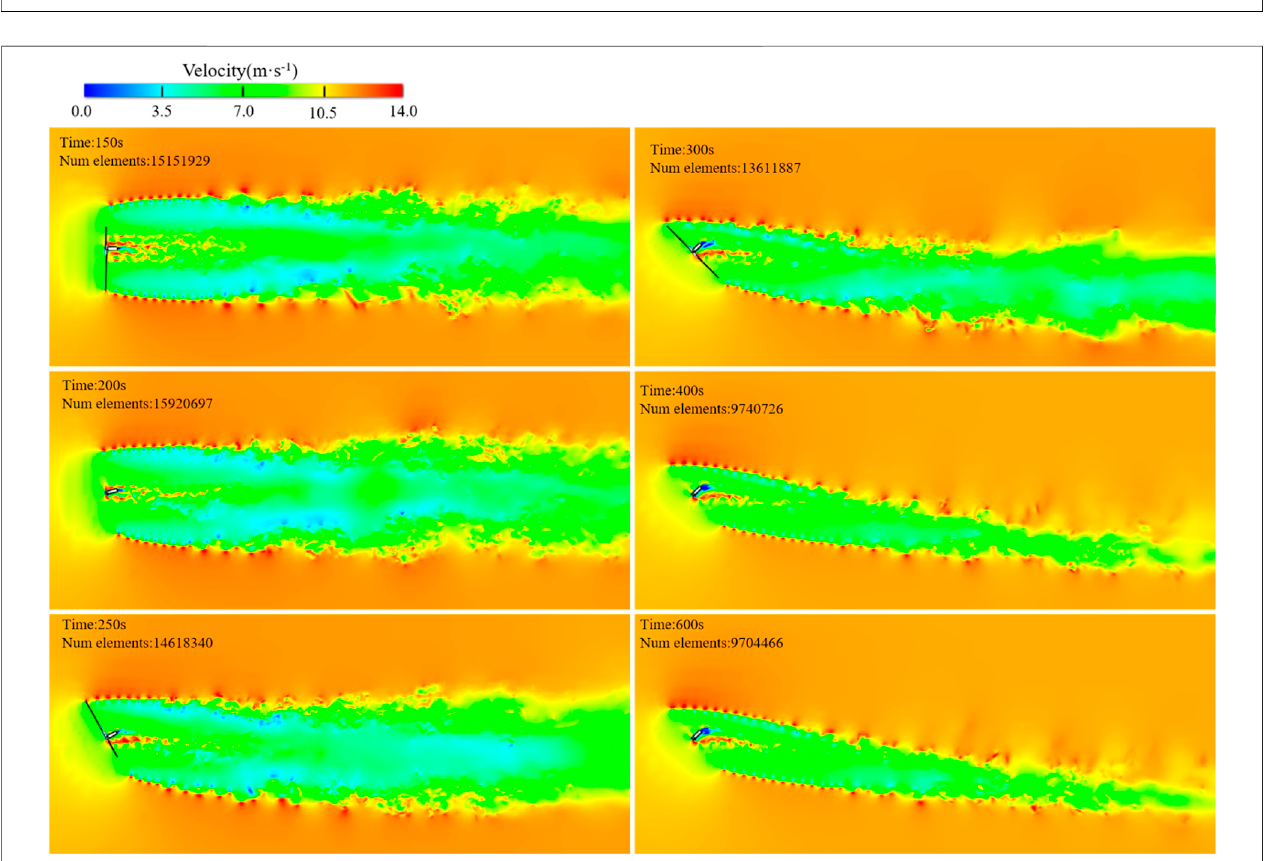
FIGURE 12 | Instantaneous velocity contour of the horizontal section at the hub height under the slow dynamic yaw.